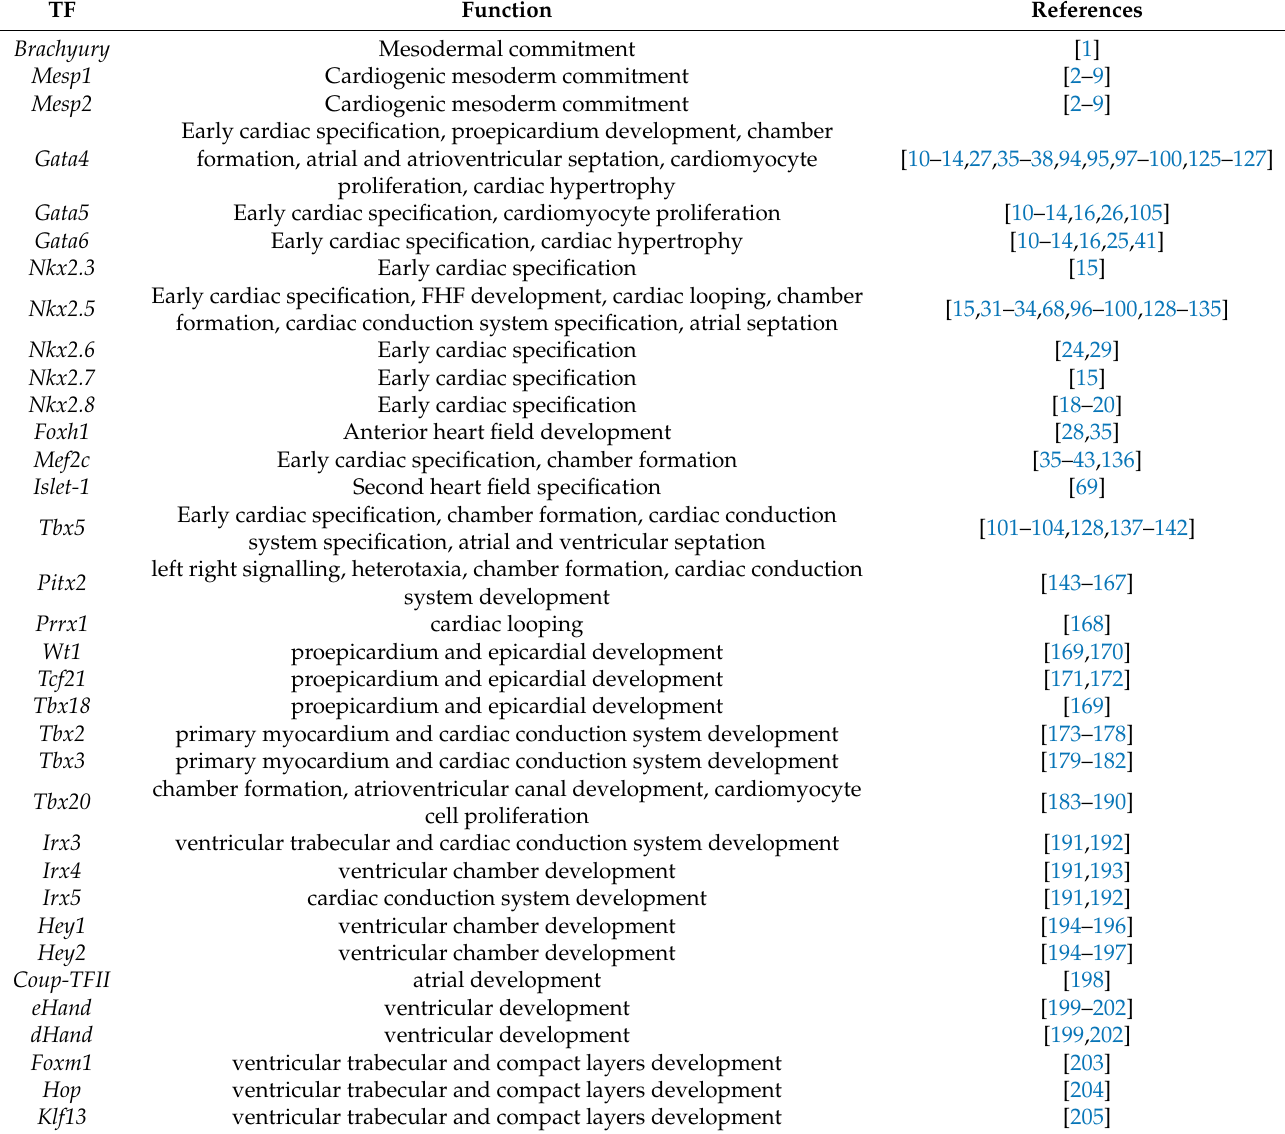
Table 1. List of distinct transcription factors involved in cardiogenesis and they main functional contribution to heart development. TF